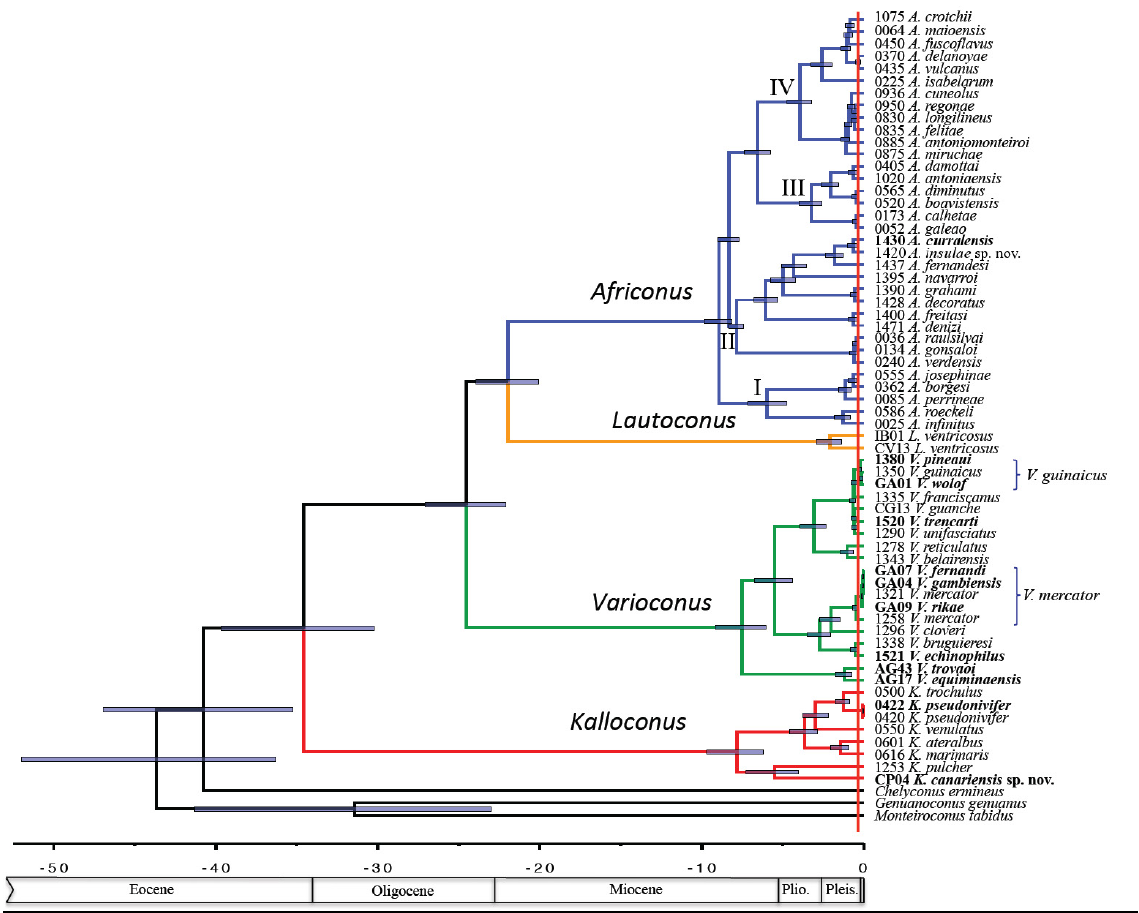
Fig. 2. Phylogenetic relationships of West African cones and species delimitation. A time tree (relaxed molecular clock) was reconstructed following methods and calibrations in Abalde et al . (2017a). Dates are in million years. Bold names indicate new mitogenomes. A red line indicates the threshold (uncorrected p distance of 0.2%, based on the divergences between Africonus verdensis (Trovão, 1979) and its sister group and Varioconus guanche (Lauer, 1993) and its sister group) for species